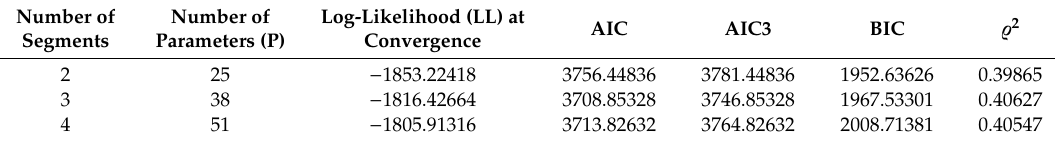
Table 4. Statistics to determine the optimal number of consumer